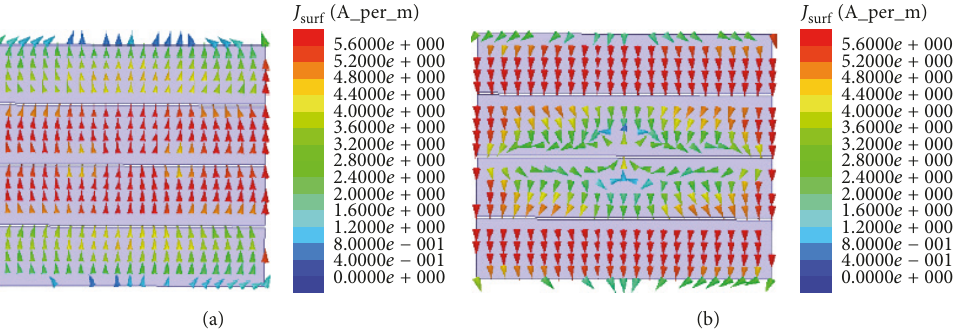
Figure 5: Simulated surface current distribution on MP III at resonance frequencies. (a) 4.5 GHz. (b) 5.5 GHz.